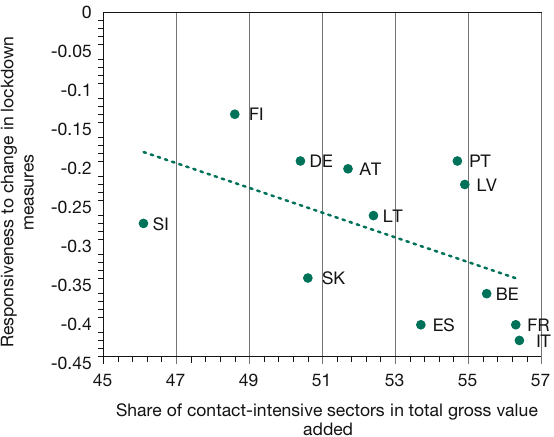
Figure 7 Responsiveness to a change in lockdown measures across the euro area